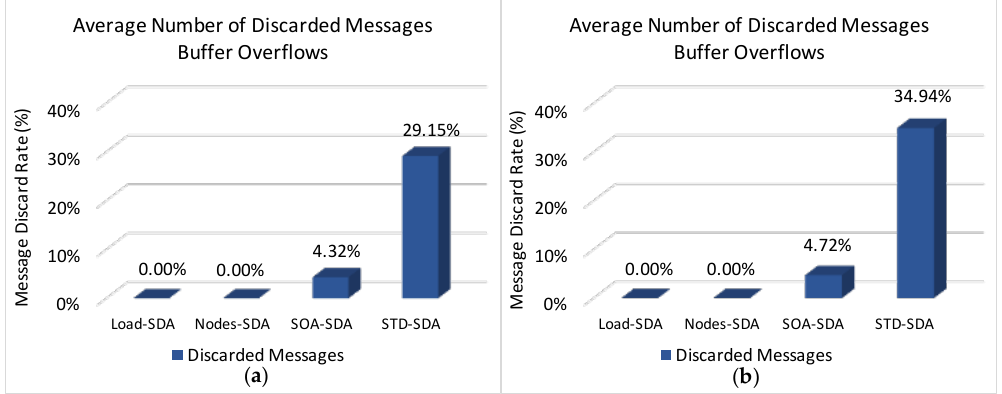
Figure 14. Average discard message rate due to buffer overflows: ( a ) Unconditioned Scenario; ( b ) Conditioned Scenario.